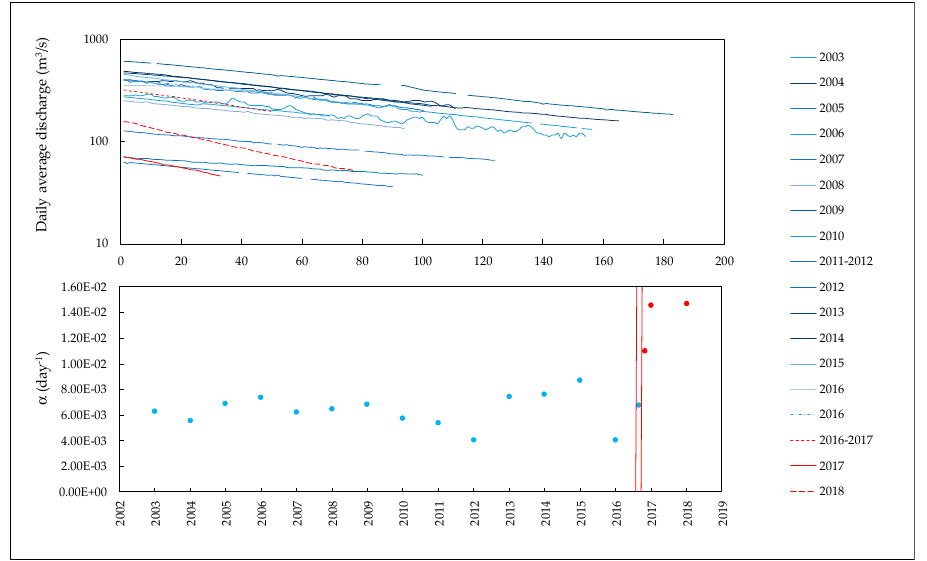
Figure 5. The depletion coefficients, α , for the years 2003–2018. Blue lines and dots indicate pre-earthquake recession periods, red lines and dots are related to post-earthquake periods. Vertical red bars indicate the 24 August and the 30 October 2016 seismic shocks.